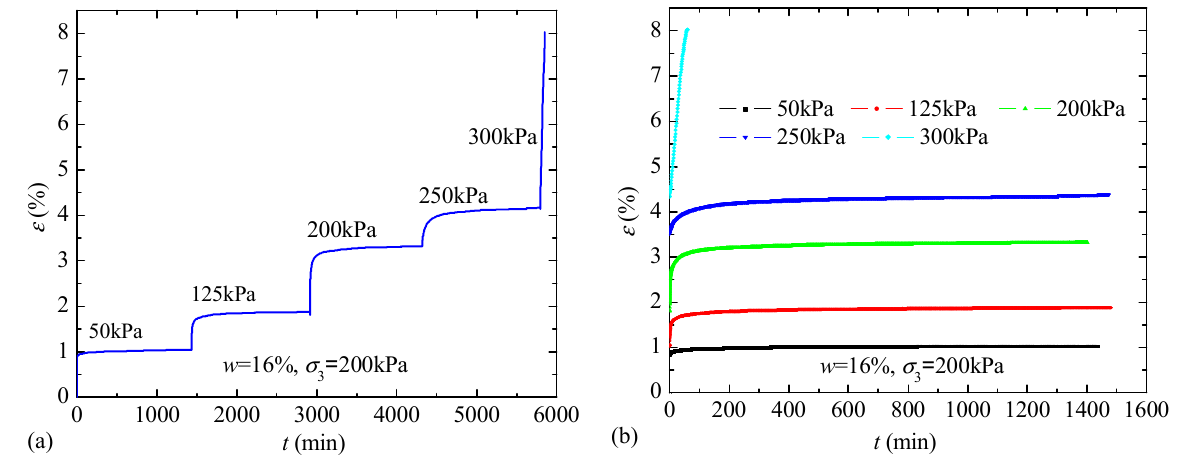
Figure 7. ( a ) The whole process curve of creep for loess with 10 dry-wet cycles, ( b ) creep curves of loess with 10 dry-wet cycles.